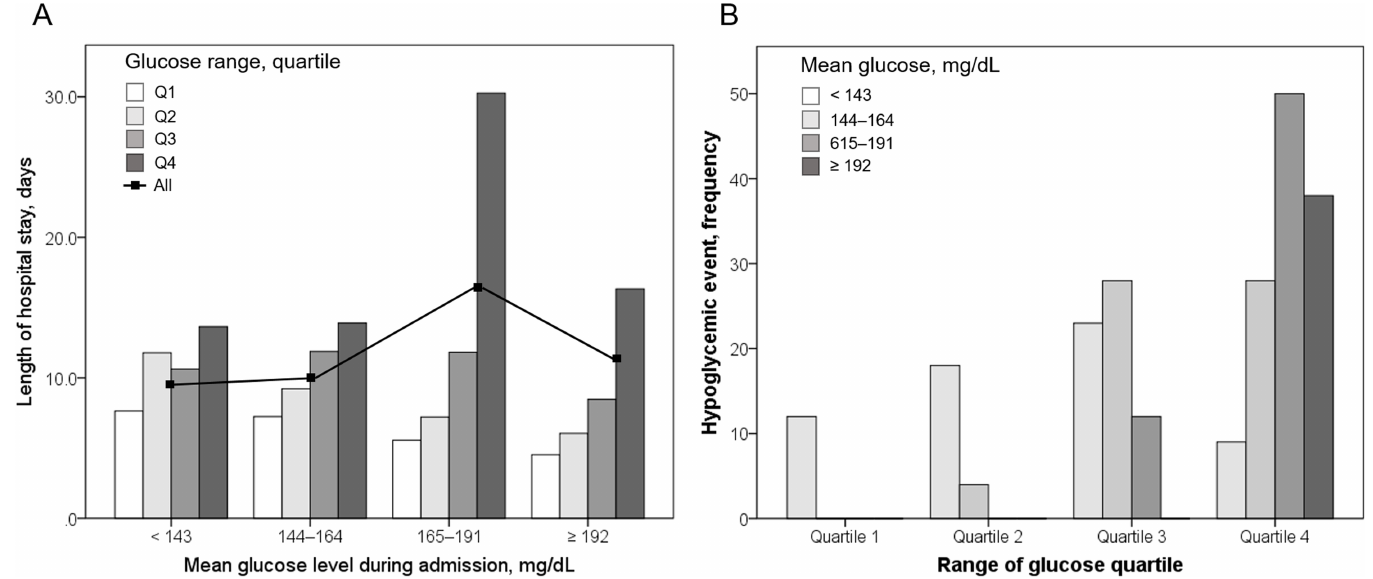
Fig 3. Relationship betweenlength of hospitalstay (A), frequency of hypoglycemic event (B) and glucoseparameters duringadmission.